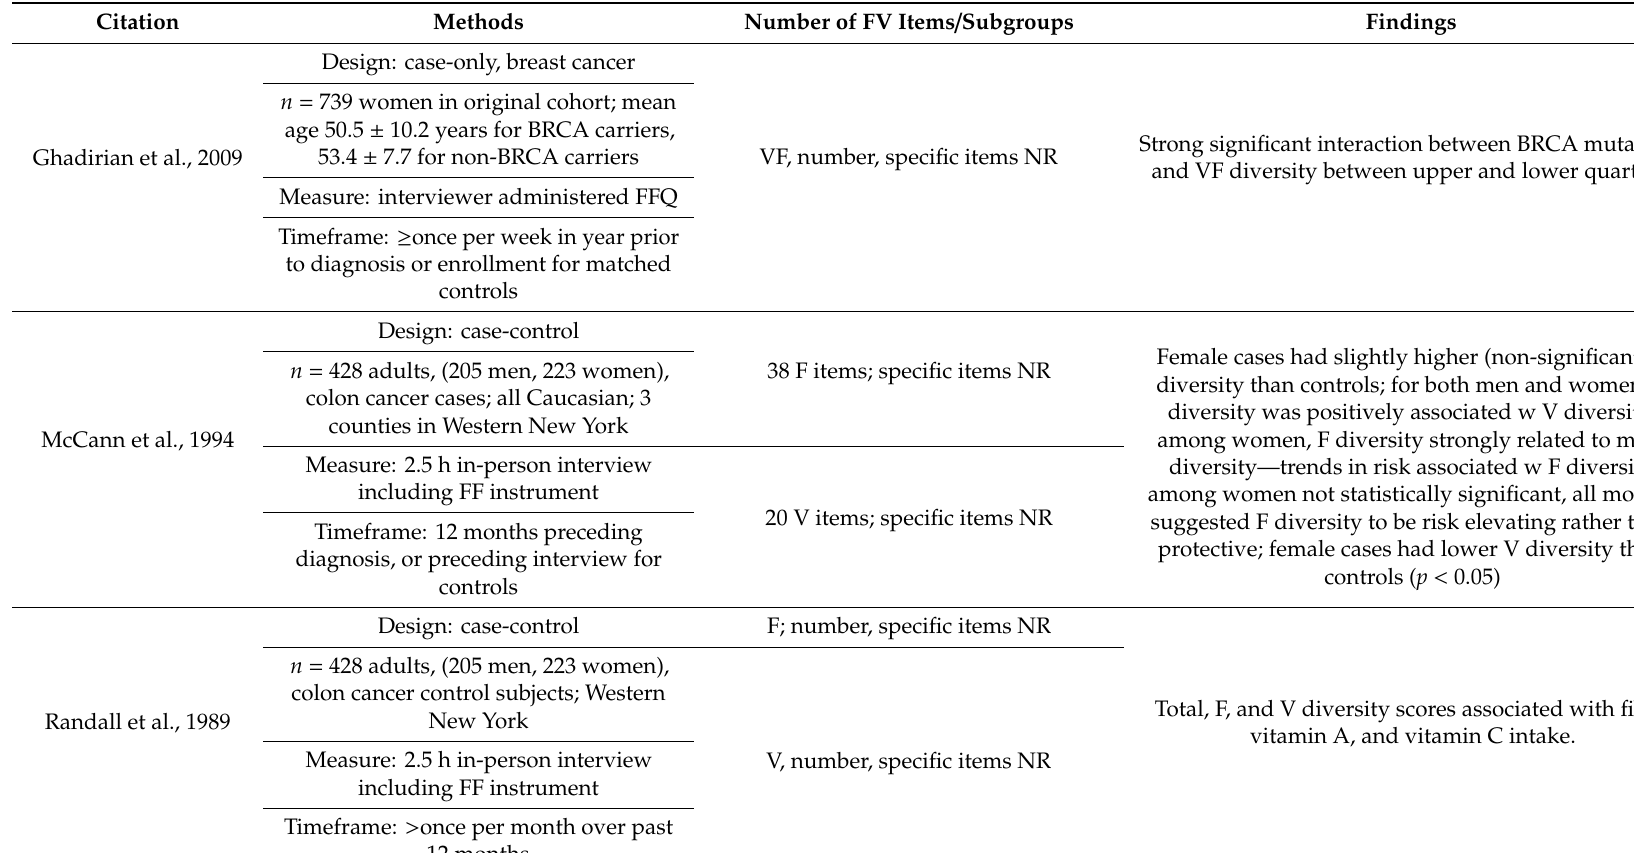
Table 5. Case-only and case-control studies assessing fruit and vegetable variety in the